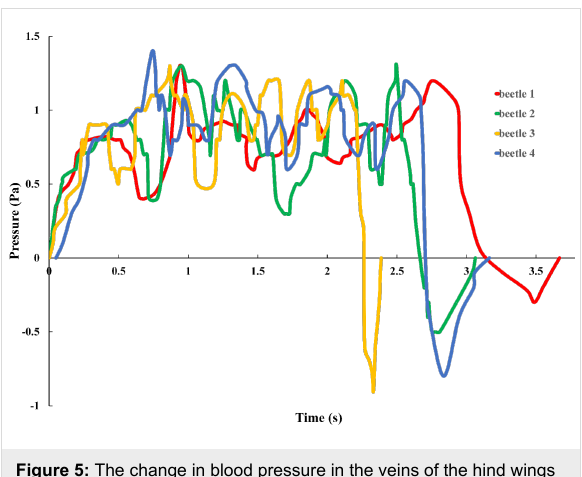
Figure 5: The change in blood pressure in the veins of the hind wings as a function of time.